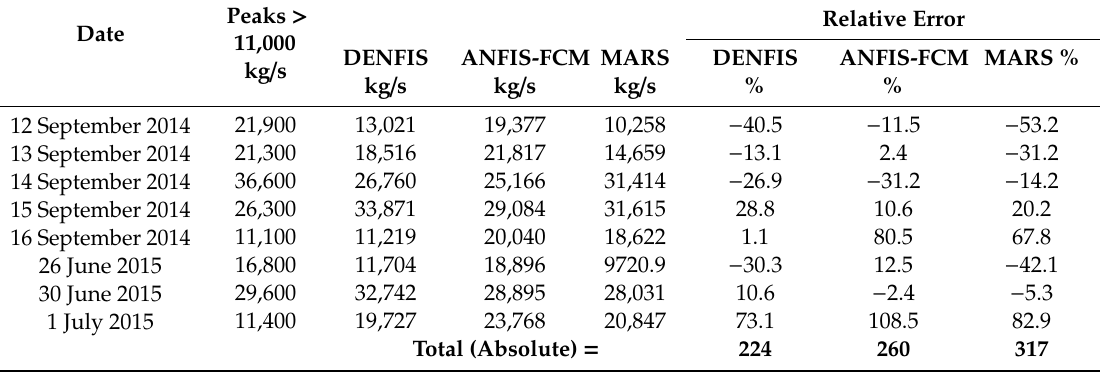
Table 5. The comparison of DENFIS, ANFIS-FCM and MARS peak-estimates for the test period, Beibei